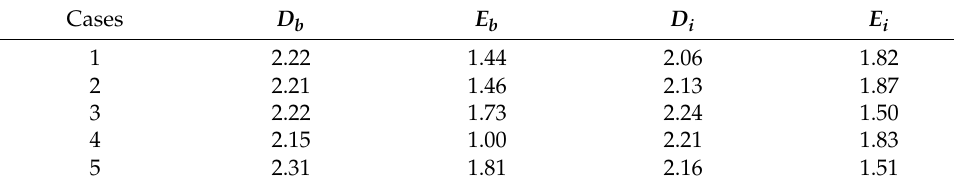
Table 4. Parameters to predict the turbulence intensity in each